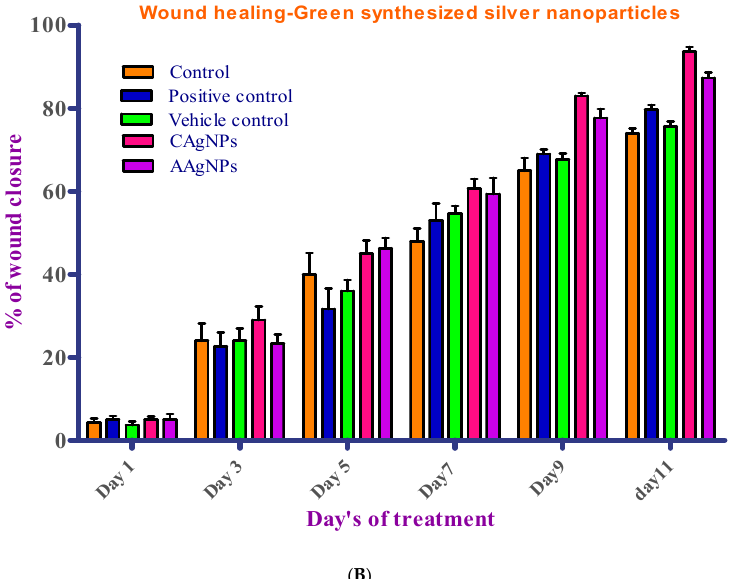
Figure 9. ( A ) Representative photographs showing wound closure after treatment with green-synthesized silver nanoparticles of C.roseus and A.indica (1% w / w ) and control groups on days 0, 1, 3,5,7,9, and 11.( B ) Effect of topical application of green-synthesized silver nanoparticles of C.roseus and A.indica (1% w / w ) on percent wound closure on different days in BALB/c mice. Table 2. Percentage of wound contraction in BALB/c mice excision wound model. Note: mean± SE. Group